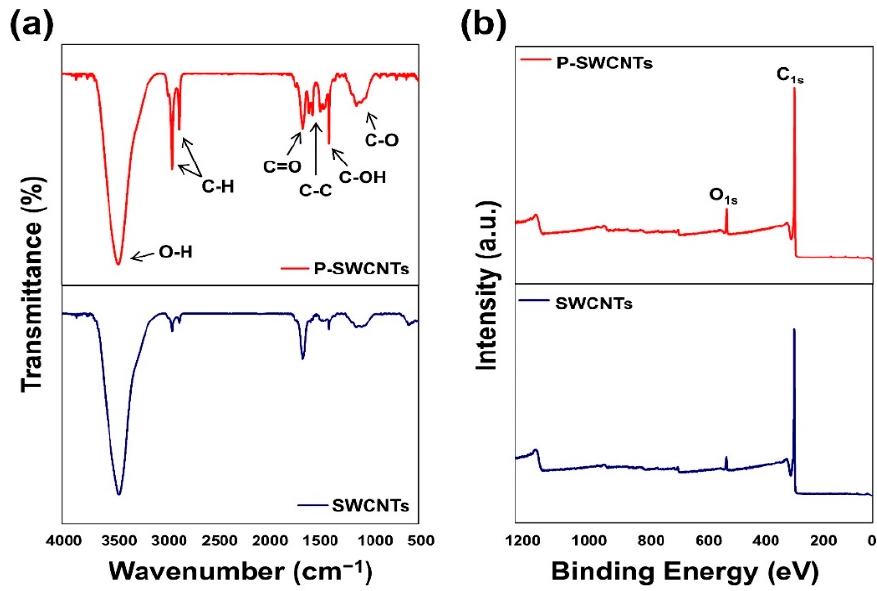
Figure 1. ( a ) FT-IR and ( b ) XPS spectra of SWCNTs and P-SWCNTs.